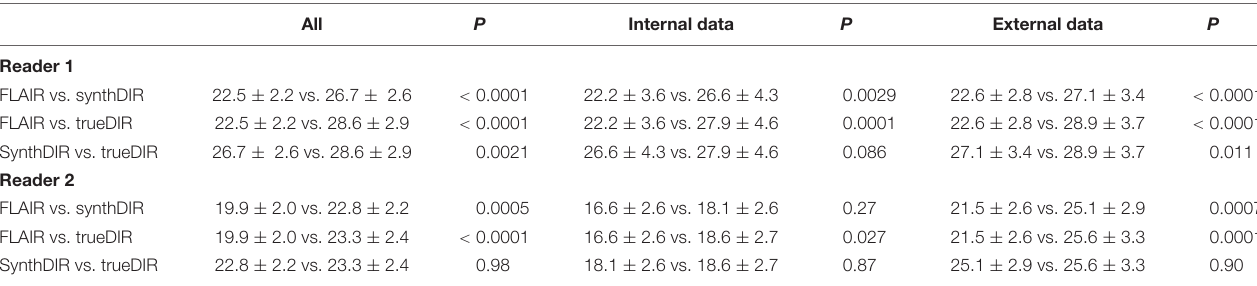
TABLE 3 | Counts of MS-specific lesions for FLAIR, trueDIR, and synthDIR as a function of data source.